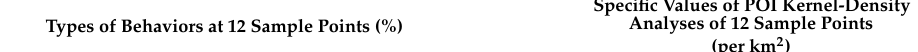
Table 2. Types of behaviors and specific values of point-of-interest (POI) kernel-density analyses of 12 sample points in Jining’s open